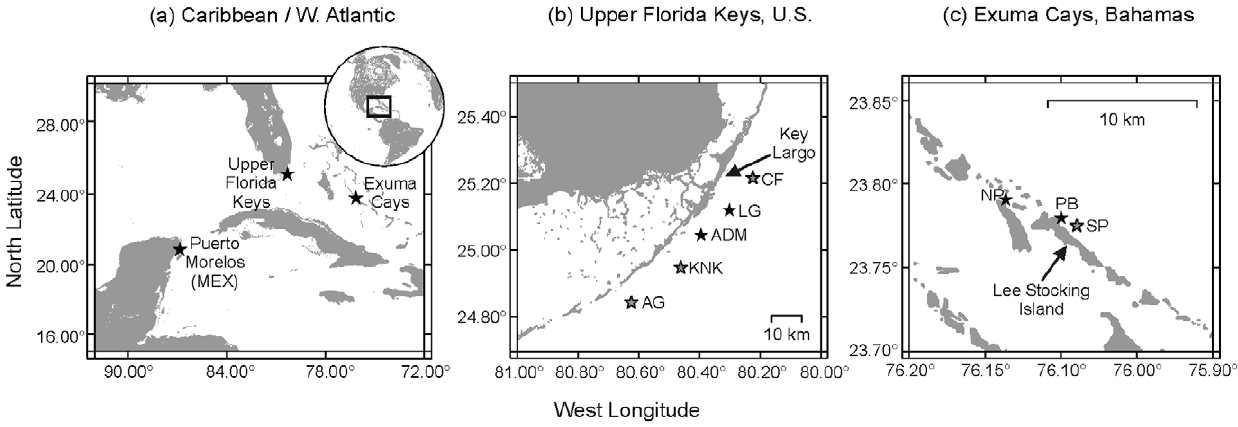
Figure 1. Regional and local maps of collection sites for this study. Coral collection depth is indicated in panels b and c by star shading; shallow reefs (1–4 m) are indicted by a black star whereas deep reefs (12–15 m) are denoted by a gray star. Reef abbreviations are as follows: Upper Florida Keys, U.S.: CF=Carysfort Reef, LG=Little Grecian Reef, ADM=Admiral Patch Reef, KNK=Conch Reef, AG=Alligator Reef; Exuma Cays, Bahamas: NP=North Norman’s Patch Reef, PB=Palmata Beach Reef, SP=South Perry Reef; Puerto Morelos, Mexico: MEX=UNAM. Figure adapted from Thornhill et al. [20].